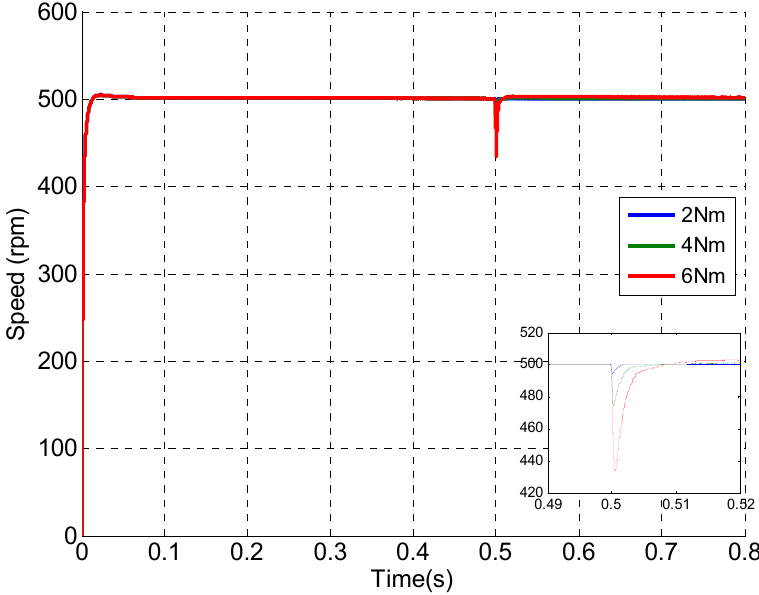
Figure 8. Speed response of FOSMC-PID speed controller for various load torque.